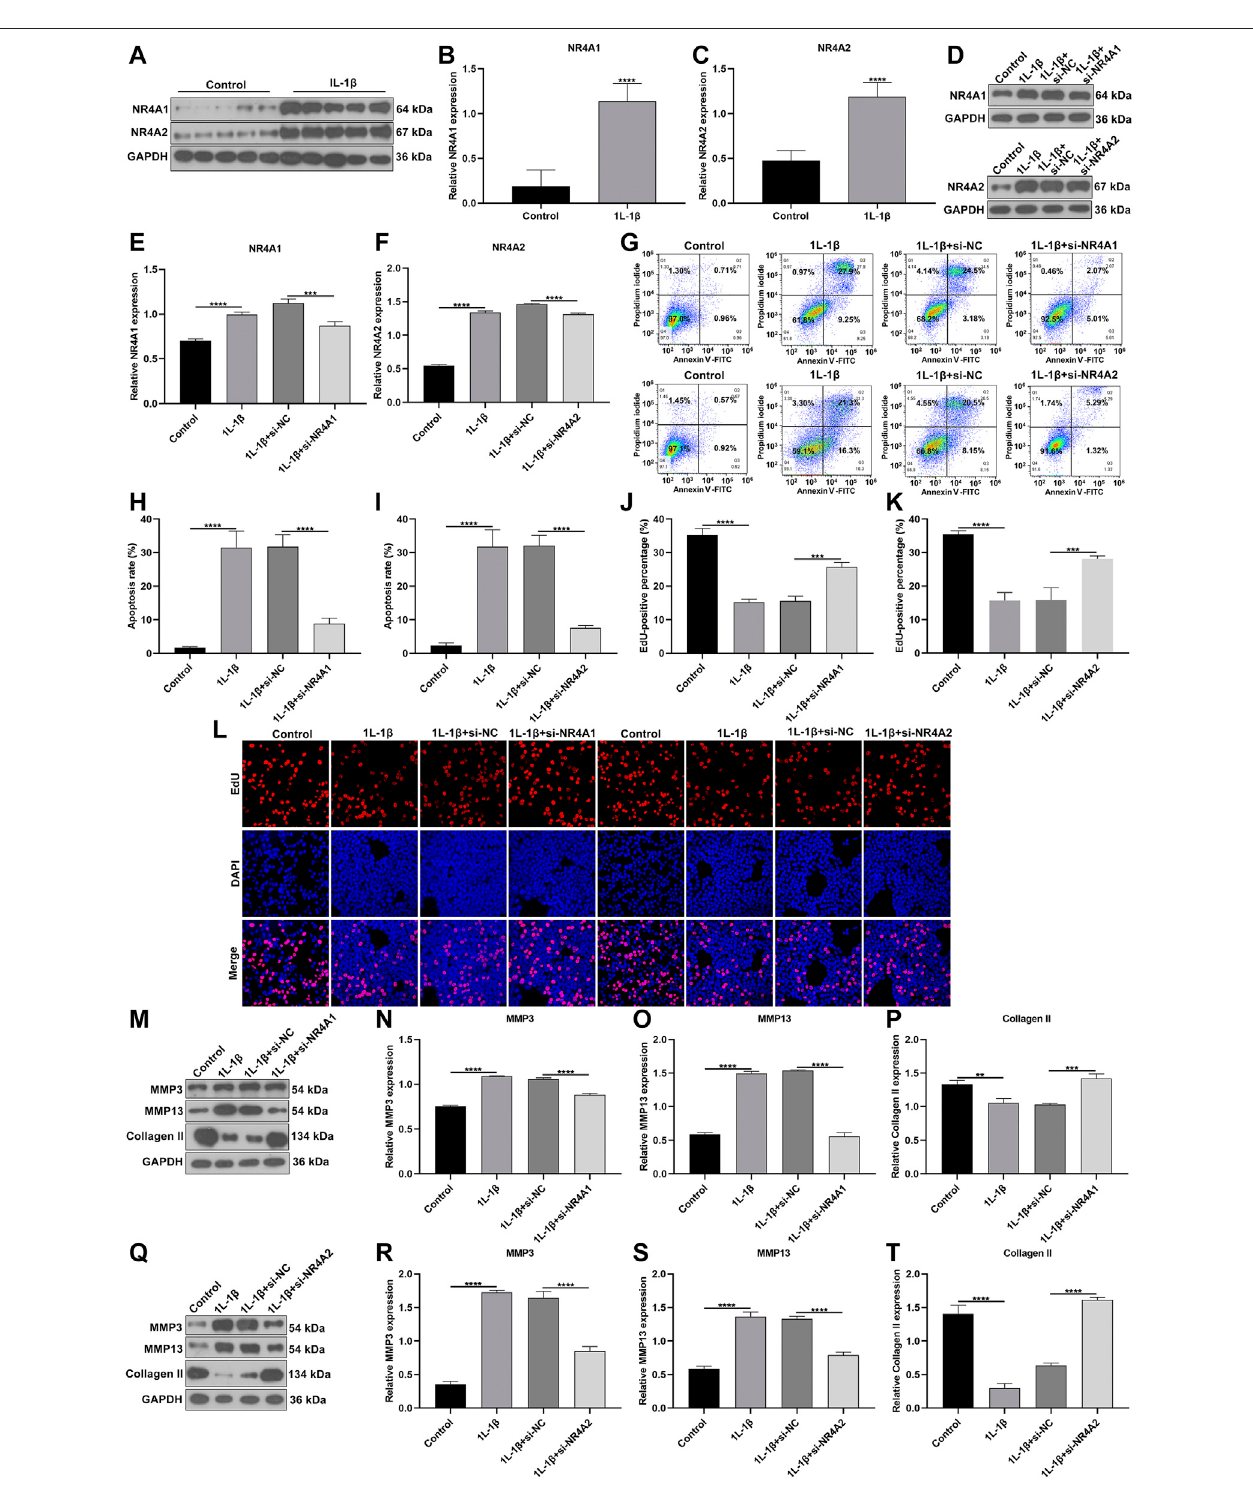
FIGURE11| SilencingNR4A1andNR4A2relievesIL-1 β -inducedchondrocytedamage. (A – C) WesternblottingoftheexpressionsofNR4A1andNR4A2inIL-1 β - induced chondrocytes. (D – F) Western blotting of the expressions of NR4A1 and NR4A2 in IL-1 β -induced chondrocytes after silencing NR4A1 or NR4A2. (G – I) Flow cytometrydetectingtheapoptosisofIL-1 β -inducedchondrocyteswithknockdownofNR4A1andNR4A2. (J – L) EdUassaymeasuringtheproliferationofIL-1 β -induced chondrocytes with knockdown of NR4A1 and NR4A2. (M – T) Westernblotting ofthe expressions ofMMP3, MMP3 and Collagen II in IL-1 β -induced chondrocytes under knockdown of NR4A1 and NR4A2. ** p < 0.01; *** p < 0.001; **** p < 0.0001.